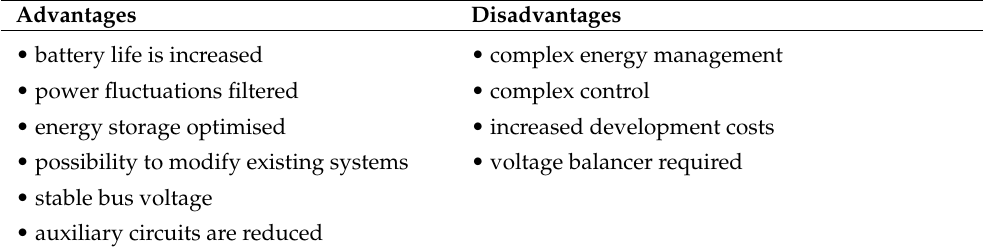
Table 14. Advantage and disadvantages Topology